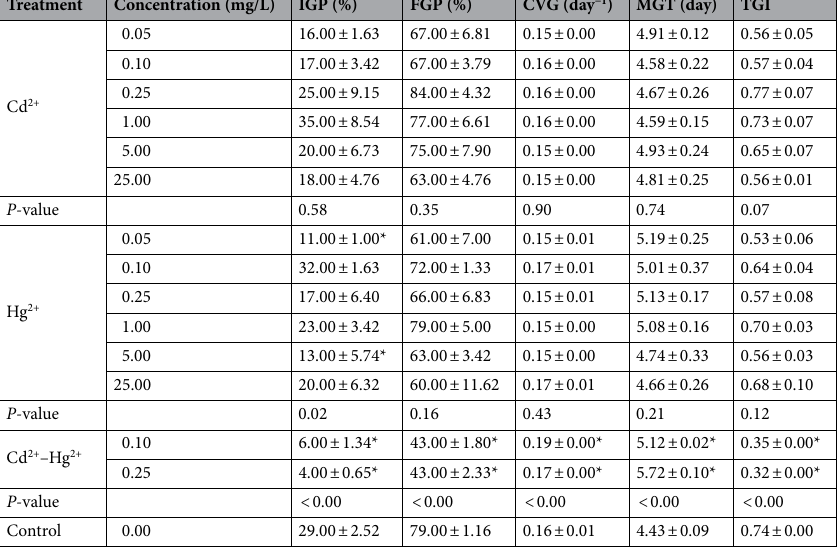
Table 2. Germination parameters of L. perenne exposed to Cd 2+ Hg 2+ and Cd 2+ –Hg 2+ . The * represents the levels of concentration statistically